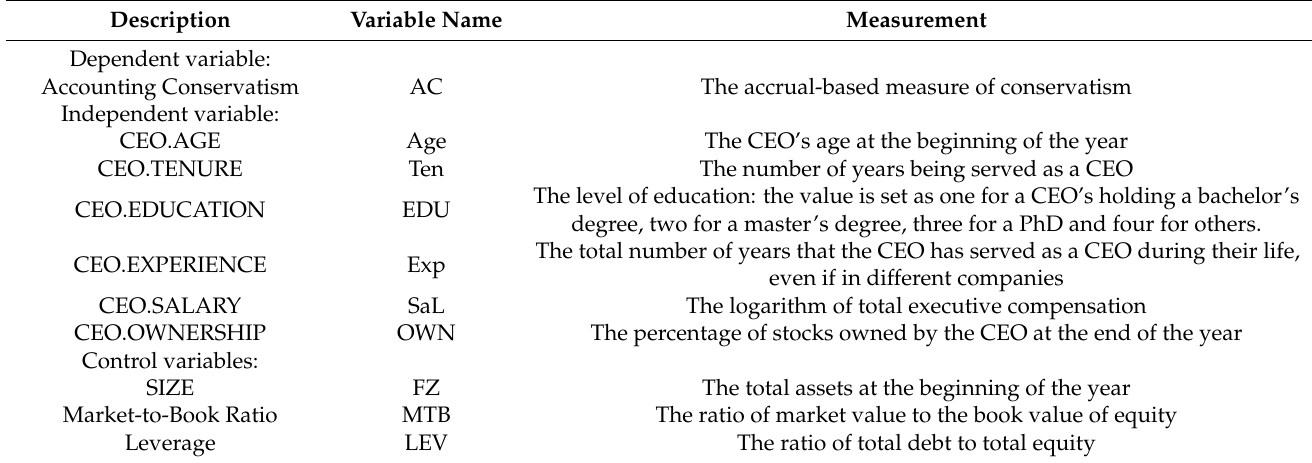
Table 1. Summary of variables’ definitions and